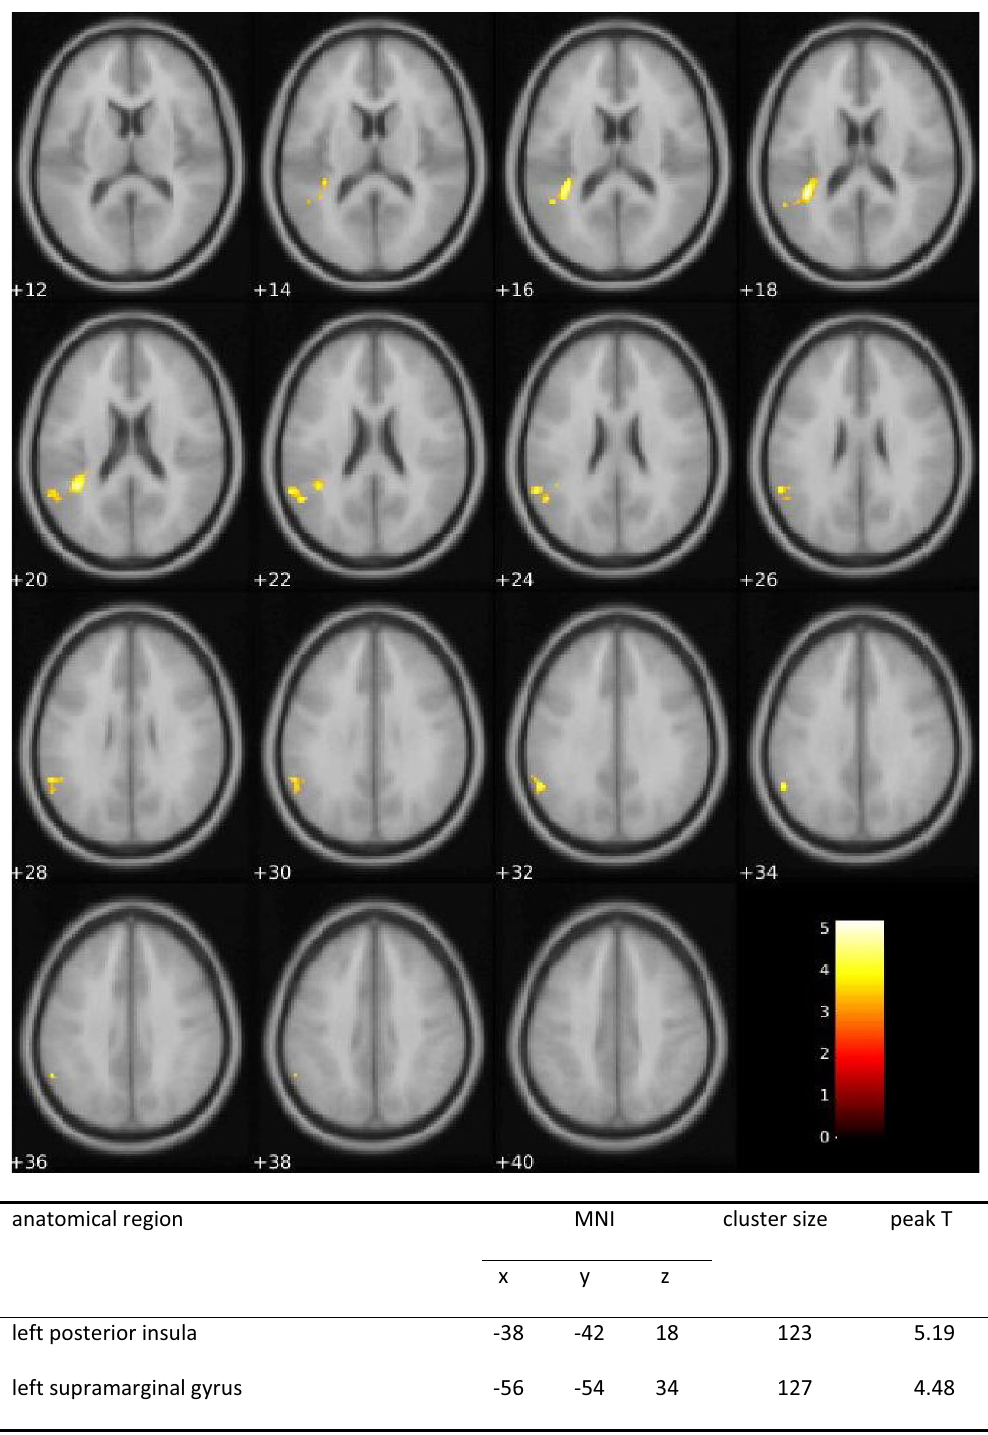
Figure 4. Moral task fMRI effects of substance: Positive activation change of posterior insula and supramarginal gyrus of the left hemisphere after one month of TRP-enriched diet (compared to placebo) during reading morally bad behavior without negative consequences for the potential victim (NP condition; axial view; colors indicate t -values; cluster defining threshold p unc. < .001, minimum cluster size 100 voxel, cluster p < .05 FWE cor.